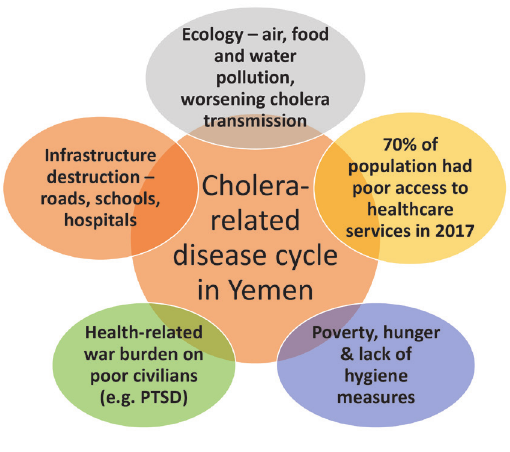
Figure 2. Cholera Migration & Global